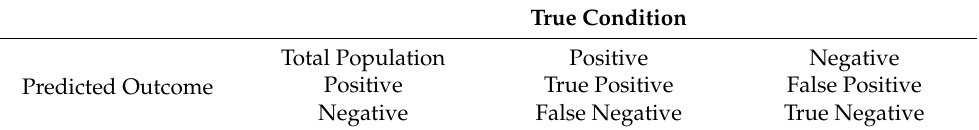
Table 6. Binary confusion